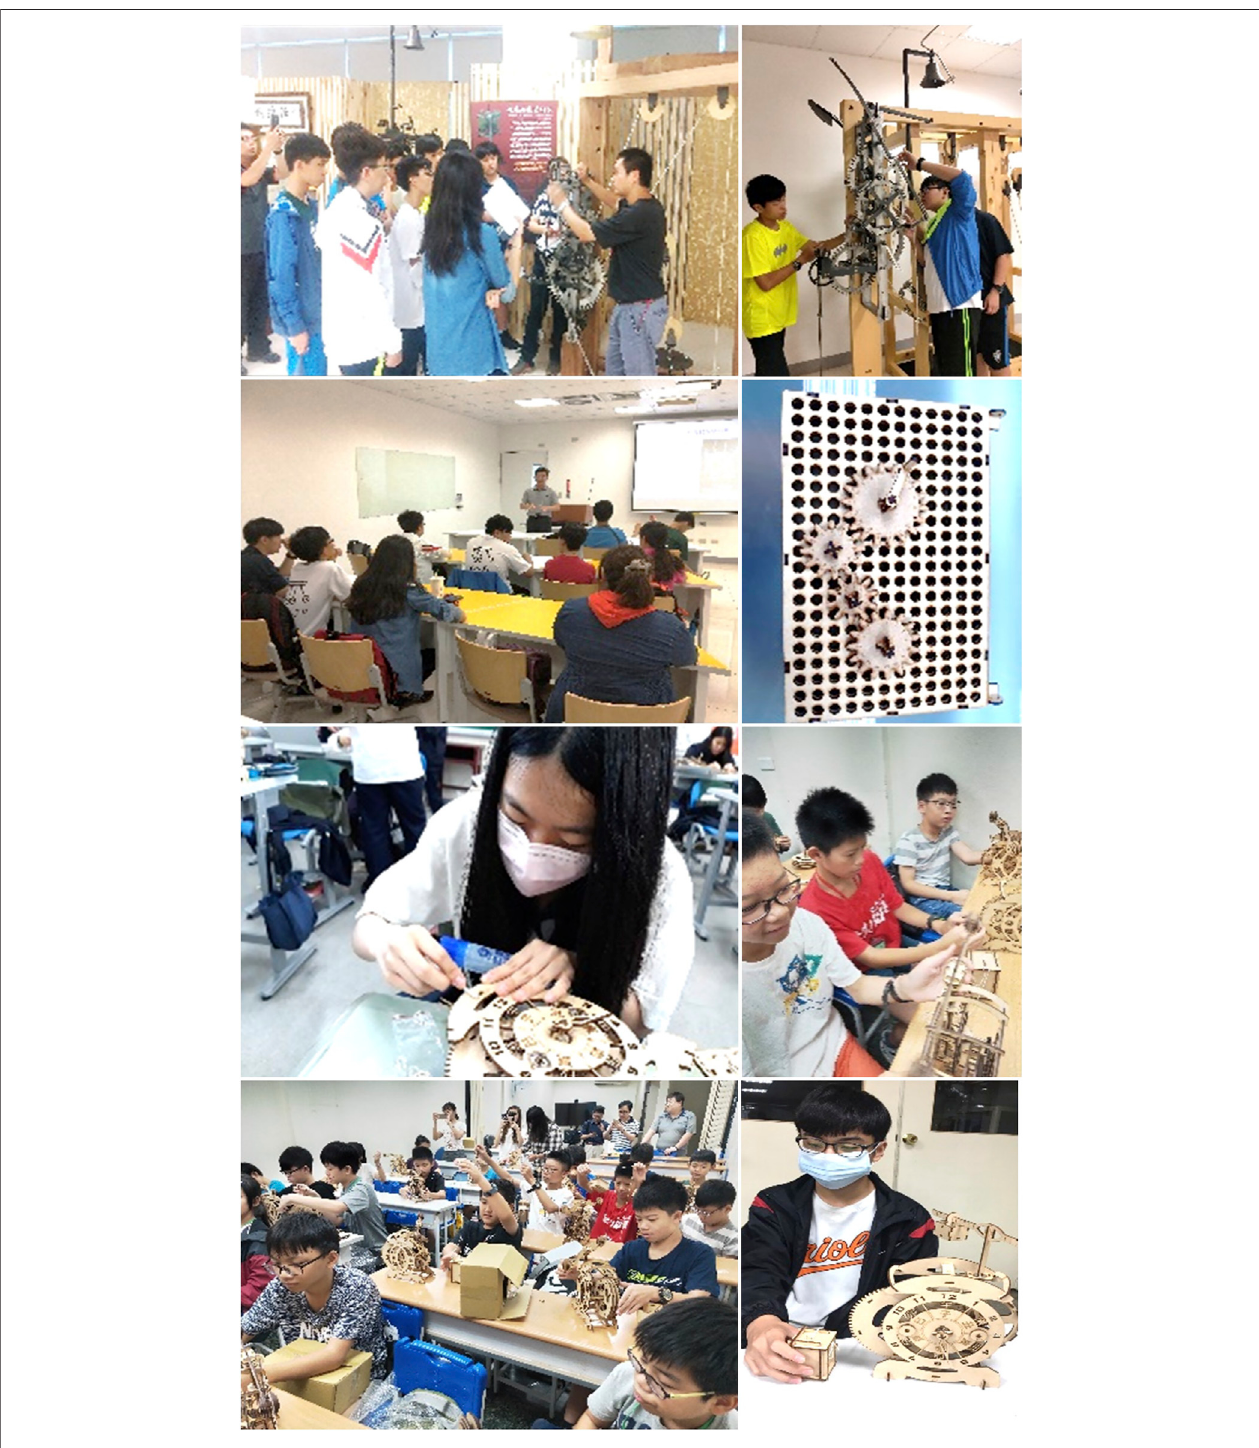
FIGURE 2 | Photos of students participating in the study.